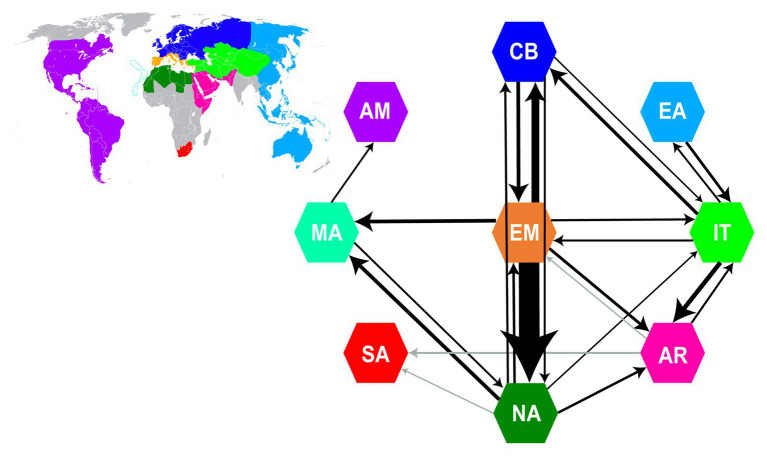
Summary of dispersal events from Biogeographical Stochastic Mapping (BSM) analyses. Arrows and their thickness represent the direction and frequency of dispersals between areas, respectively. Only event counts with a mean of ≥0.9 in both trees (“Supermatrix-ITS-like” and “Supermatrix-cpDNA-like”) are depicted as arrows (detailed results of BSM analyses in Supplementary Table S8). Gray arrows represent dispersal events with a mean ≥0.9 in only one of the two trees. The nine areas used in BSM analyses are color coded as in the world map in the upper left inset (same color coding of areas as in Figure 1). AM, America; AR, Arabia-NE Africa; CB, Circumboreal; EA, East Asia-Australia; EM, Euro-Mediterranean; IT, Irano-Turanian; MA, Macaronesia; NA, North Africa; SA, South Africa.